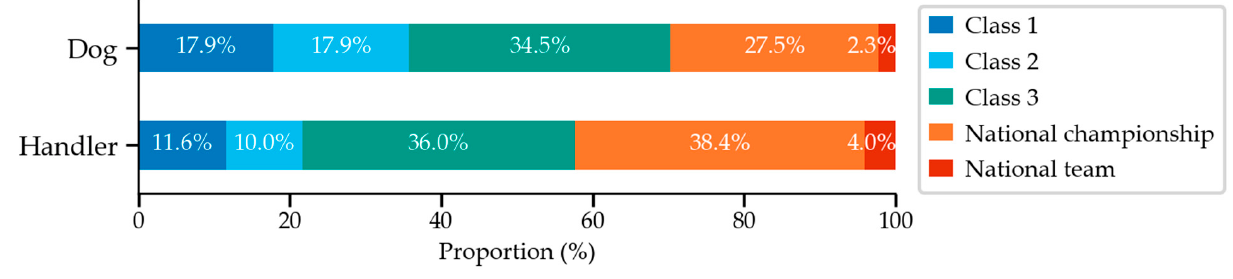
Figure 2. Dogs’ ( n = 745) and main handers’ ( n = 670) highest competition level.